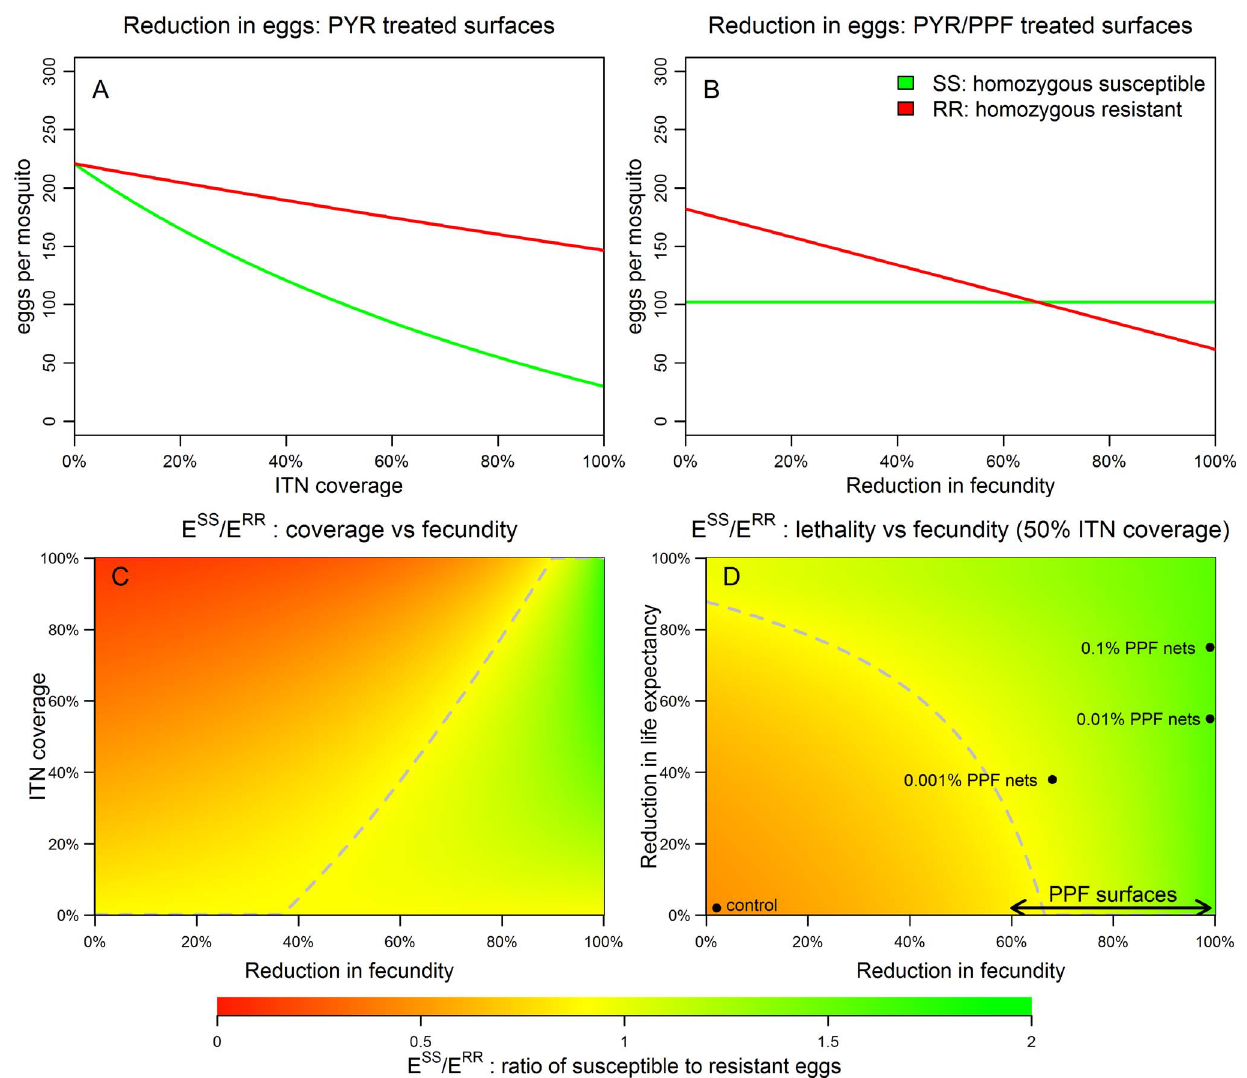
Figure 1. Reproductive fitness of pyrethroid susceptible (green) and resistant (red) mosquitoes in the presence of co-treated nets. Reduction in fecundity is defined as the proportional decrease in the number of eggs per oviposition. PYR=pyrethroid, PPF=pyriproxyfen. ( A ) Reduction in number of oviposited eggs with increasing coverage of ITNs. ( B ) Reduction in the number of oviposited eggs in presence of co-treated nets at 50% coverage. No reduction in life expectancy following PPF exposure is assumed. ( C ) Regions in parameter space where more eggs are oviposited by susceptible (green) than resistant (red) mosquitoes. No reduction in life expectancy following PPF exposure is assumed. ( D ) Regions in parameter space where more eggs are oviposited by susceptible (green) or resistant (red) mosquitoes at 50% ITN coverage. Reductions in fecundity and life expectancy observed by different concentration of PPF on bed nets by Ohashi et al [9] are represented as points. The range of reduction in fecundity seen by Harris et al [10] is represented by the black arrowed line. The dashed grey lines divide the parameter space into regions where susceptible mosquitoes are fitter than resistant mosquitoes ( E SS . E RR ), and where resistant mosquitoes are fitter than susceptible mosquitoes ( E RR . E SS ). The R code used to derive this figure is available as part of the supporting information (R code